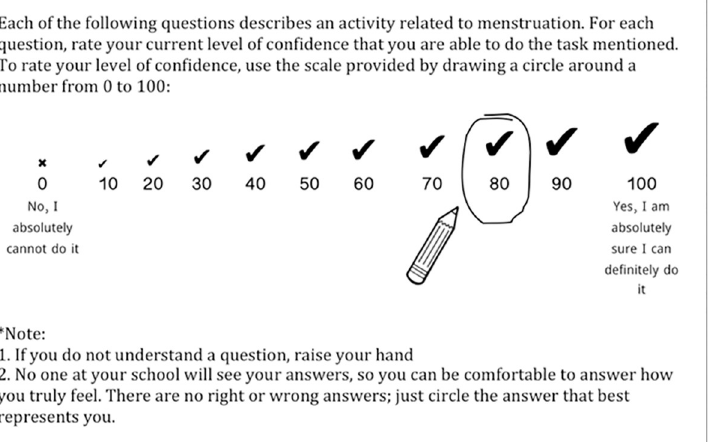
Fig 2. Questionnaire instructions and response options developed for the Self-Efficacy in Addressing Menstrual Needs Scale, tested in Bangladesh, 2017–2018.